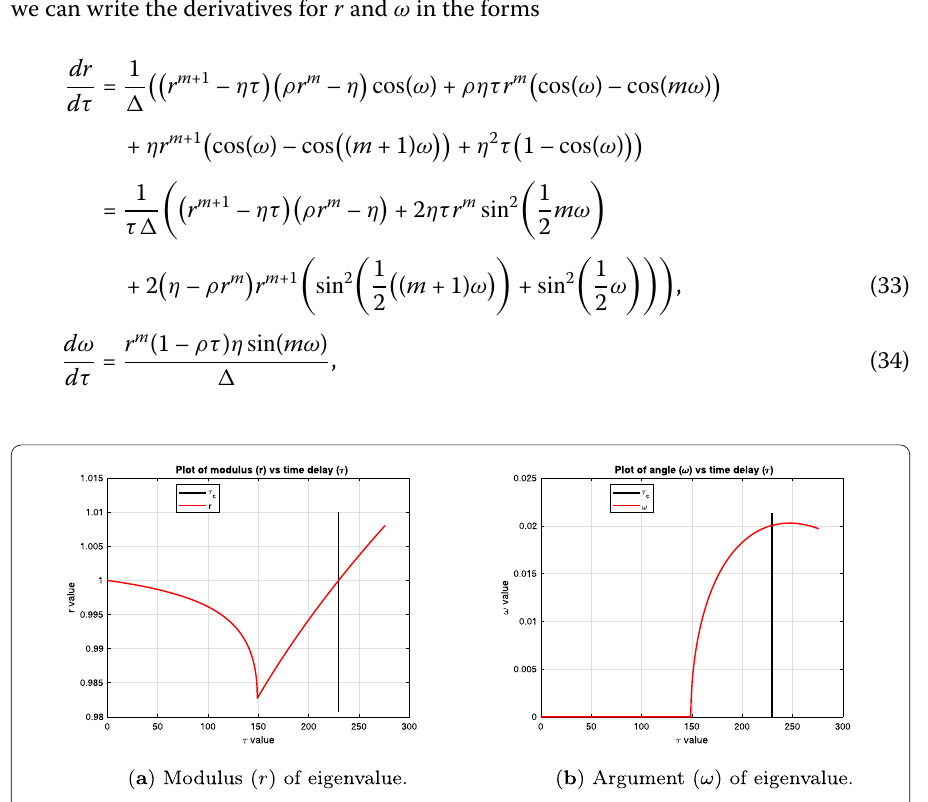
Figure 2 Plots of moduli and arguments of eigenvalues vs time delay τ . The vertical black line is at τ = τ